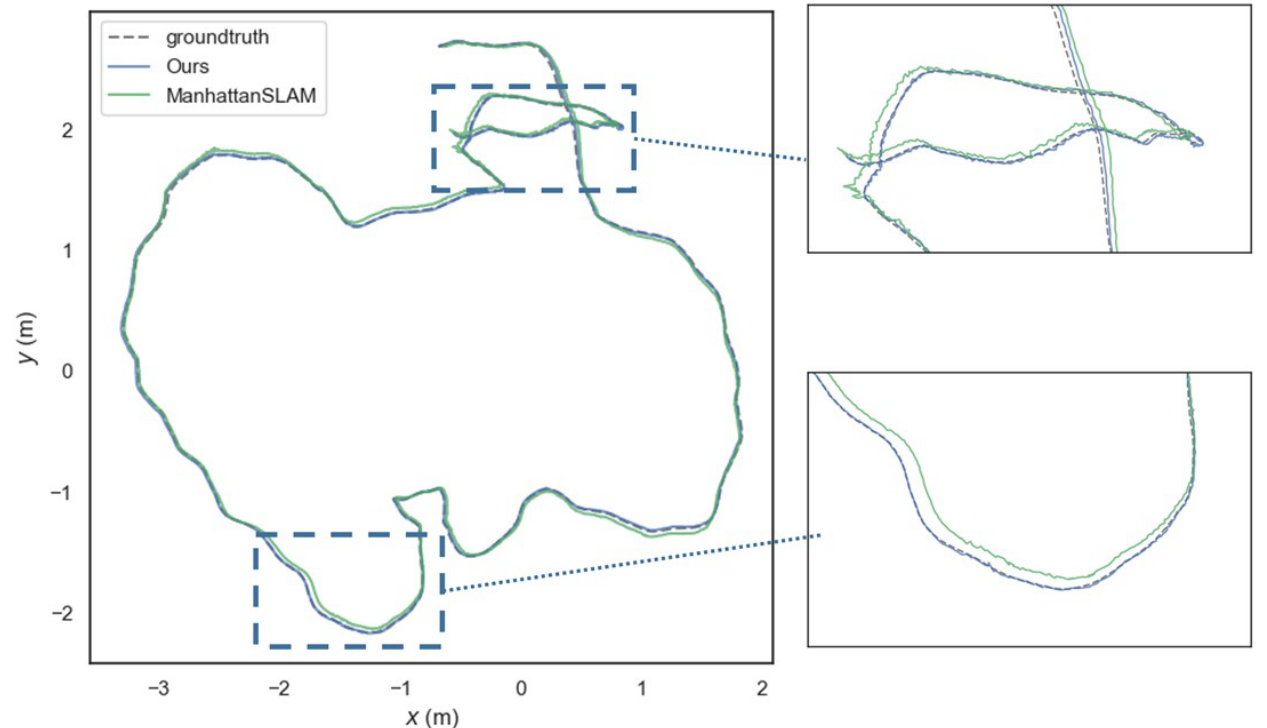
Figure 8. Left : Local map for the fr3-longoffice sequence. Right : Estimated trajectories with our method (blue) and ManhattanSLAM (green), and the ground truth (dashed grey) in TUM RGB-D dataset fr3-longoffice sequence.